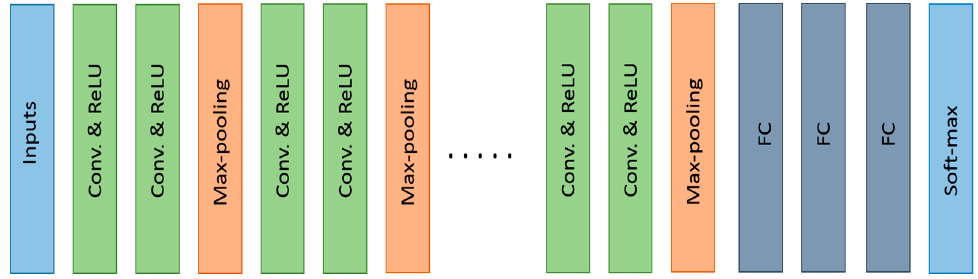
Figure 13. The basic building block of VGG network: Convolution (Conv) and FC for fully connected layers.